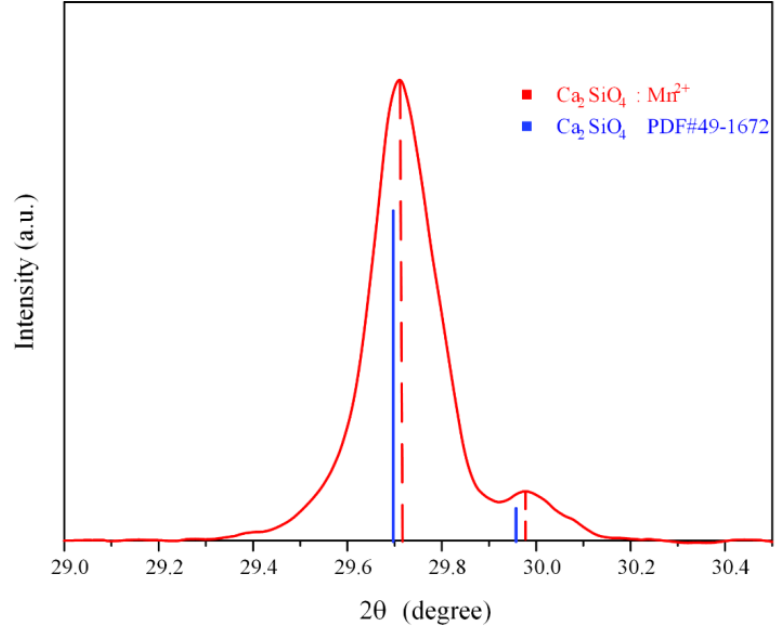
Figure 2. Peak shift of CSO:Mn 2+ in the range of 29 ◦ to 30 ◦ . Table 1. The calculated lattice parameters of pure and 2% Mn 2+ -doped Ca 2 SiO 4 samples. Under 365 nm excitation, the excitation spectrum of CSO:Mn 2+ is as shown in Figure 3a. The material has two obvious excitation peaks at 475 and 550 nm, and the peak intensity at 475 nm is obviously smaller than that at 550 Sample